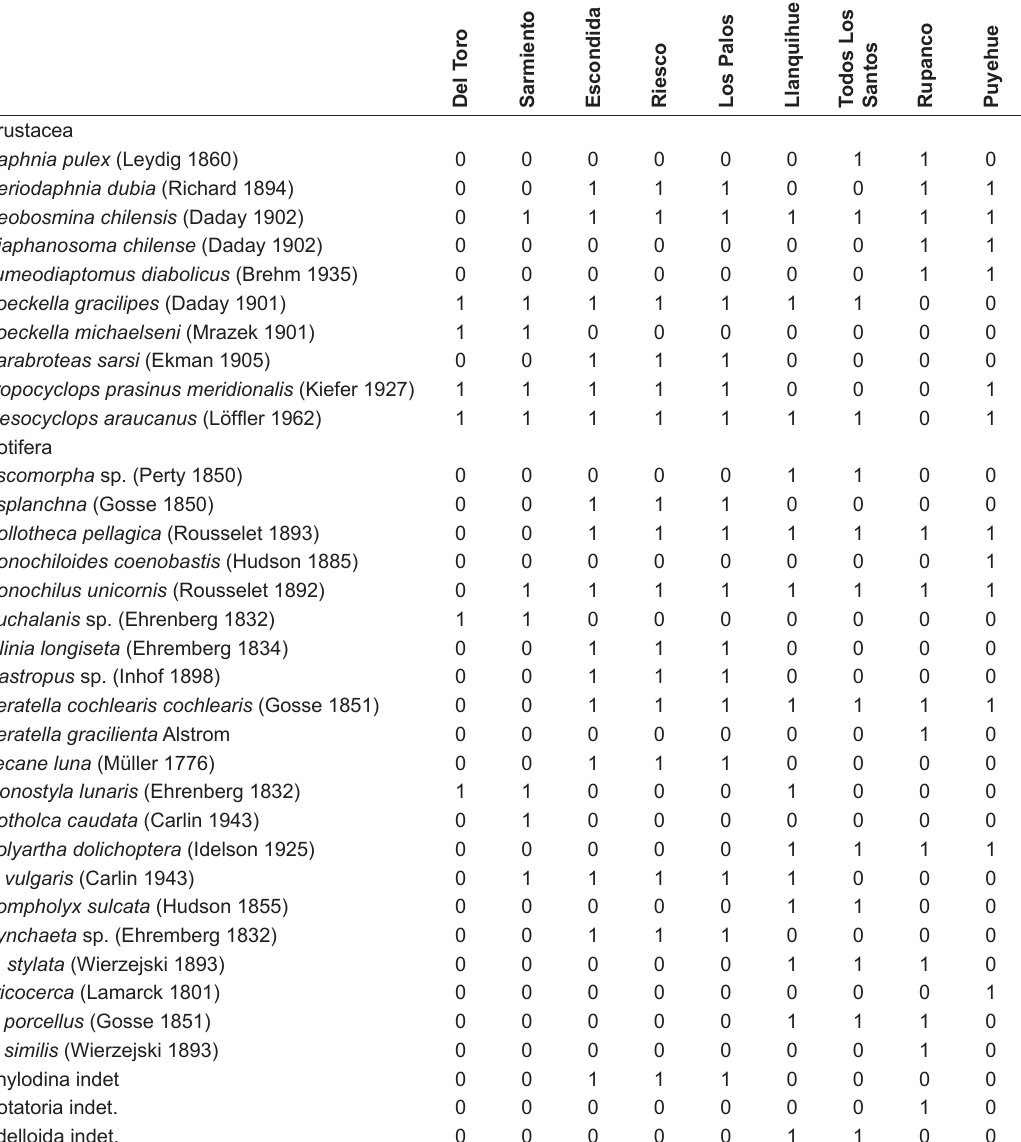
Table 2. Rotifera and crustacean species reported for sites considered in the present study.